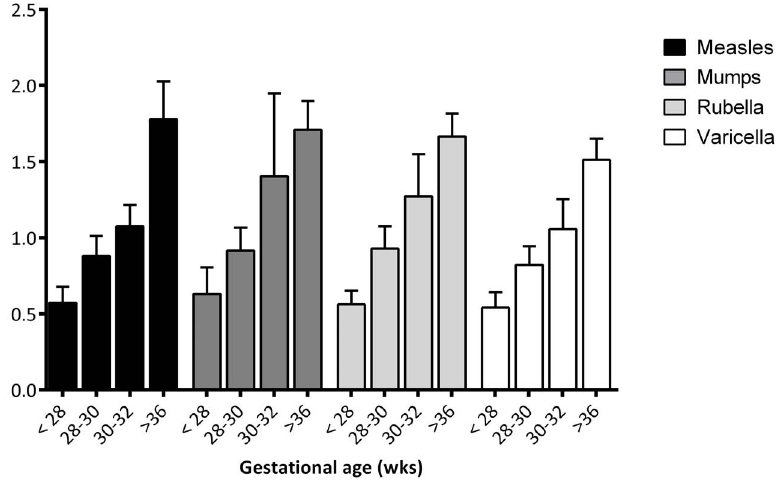
Figure 1. Transplacental transport ratio of measles, mumps, rubella and varicella with 95% confidence intervals. doi:10.1371/journal.pone.0094714.g001 PLOS ONE |